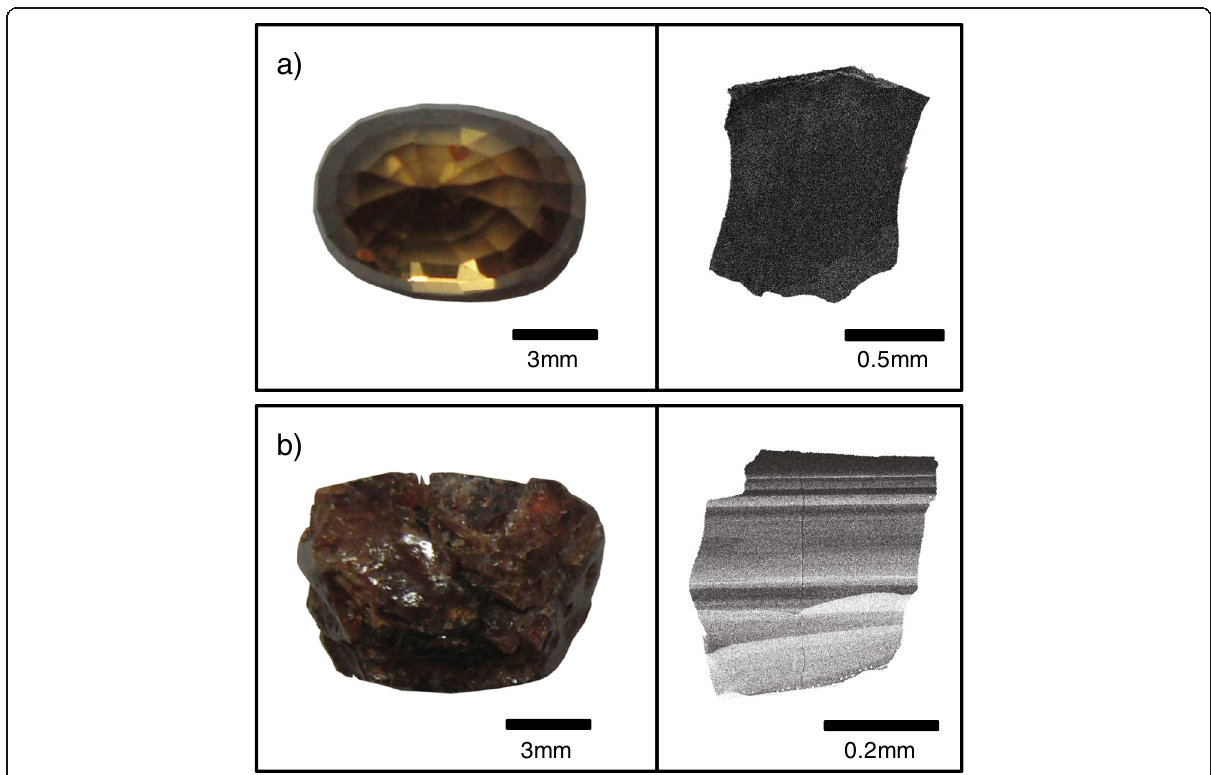
Fig. 1 Photographs of KBSI working standards ( a ) LKZ-1 and ( b ) BRZ-1 and their representative cathodoluminescence